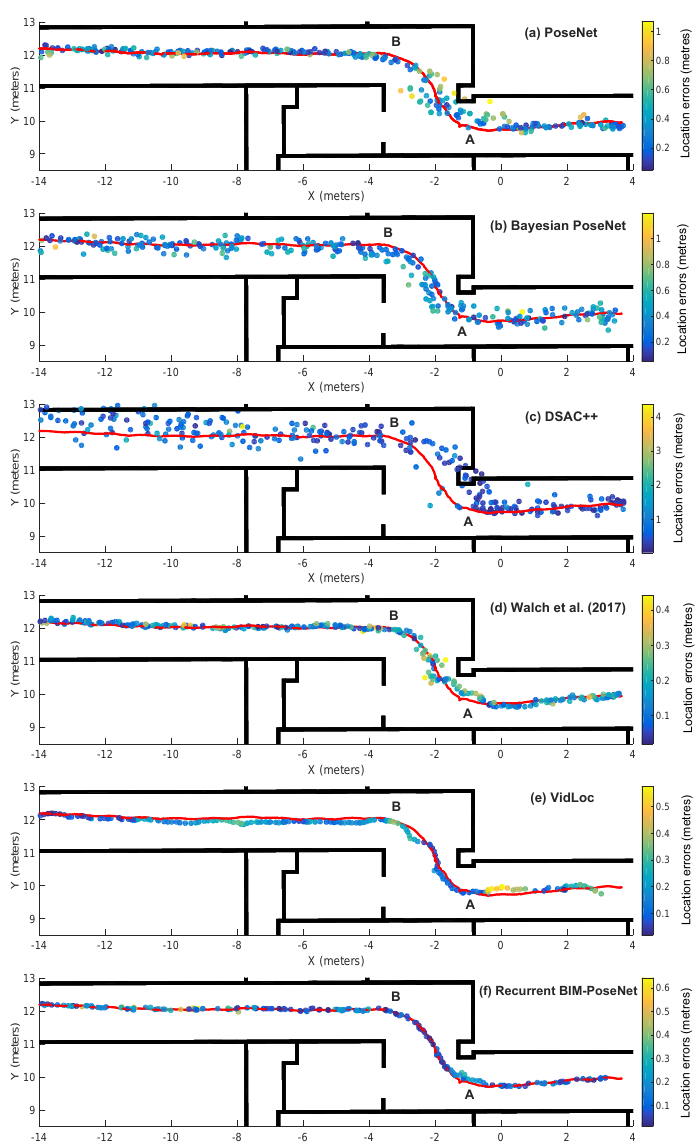
Figure 4. The predictions of ( a ) PoseNet [1], ( b ) Bayesian PoseNet [2], ( c ) differentiable RANSAC (DSAC)++ [16], ( d ) Walch et al. [4], ( e ) VidLoc [20], ( f ) Recurrent building information model (BIM)-PoseNet fine-tuned and tested using a sequence of ten real images. The colour represents the magnitude of error of each point, and the red line denotes the ground-truth